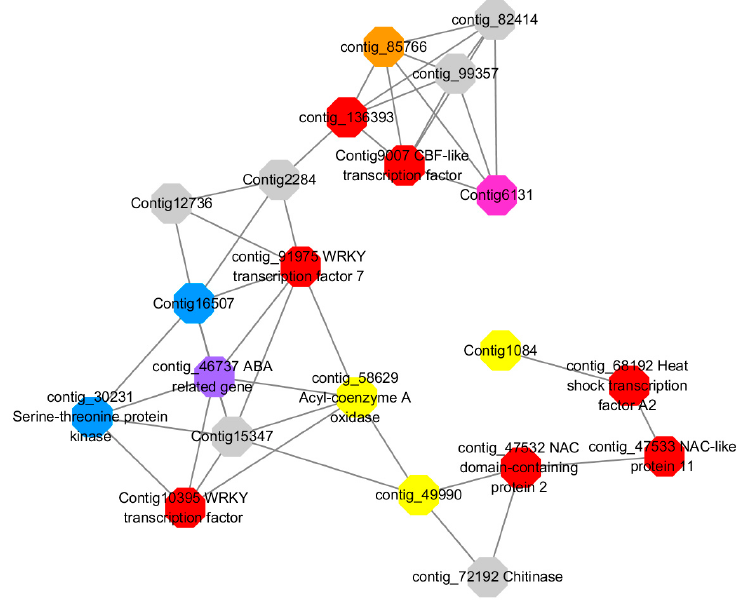
Figure 24. Interaction between genes in Module 1.